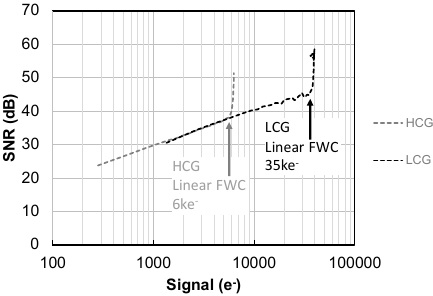
Figure 8. Signal to noise ratio (SNR) of high conversion gain (HCG) mode and low conversion gain (LCG) mode under the conditions of constant object illuminance and average of 100 frames.